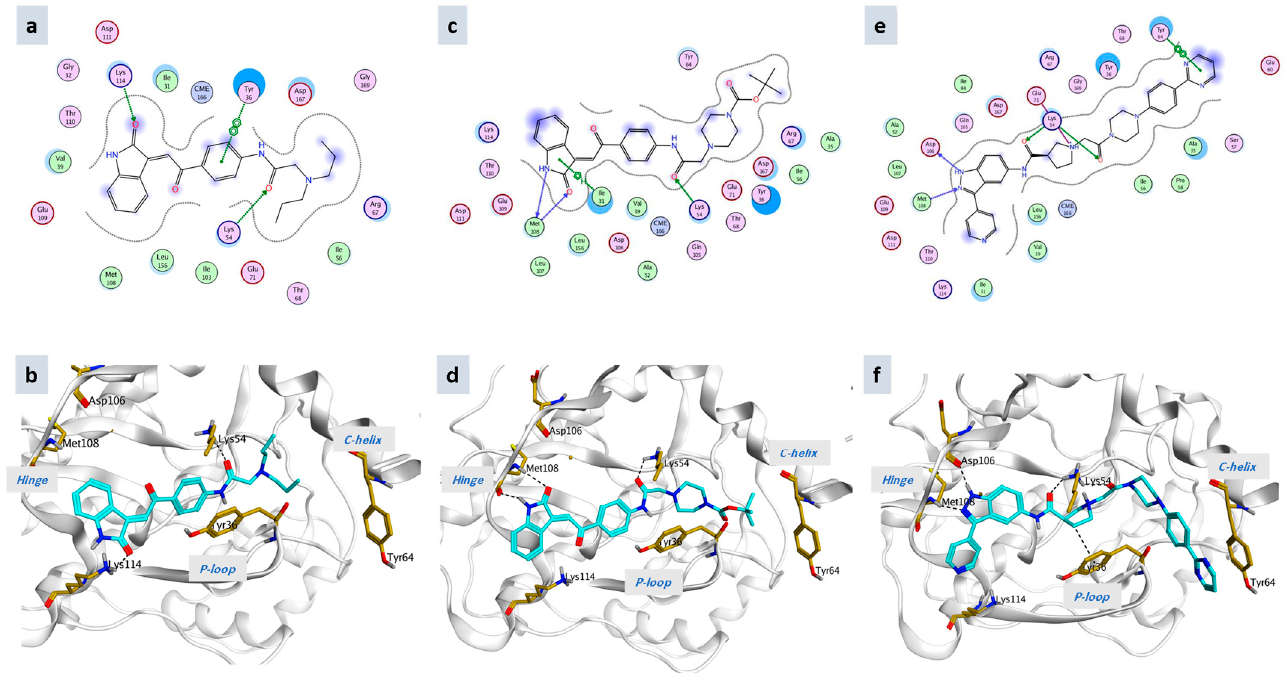
Figure 6. ( a ) 2D representation of the ligand interactions and ( b ) 3D representation of the docking